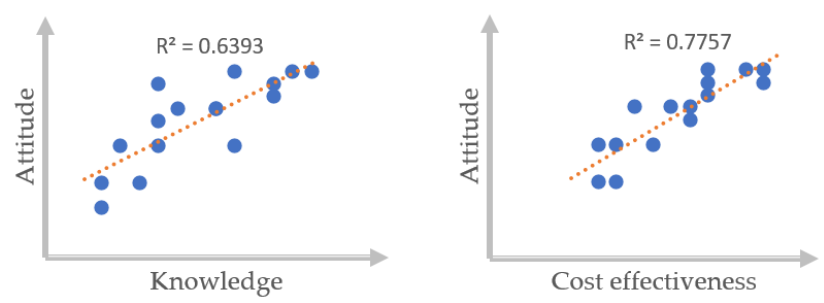
Figure 7. Significant correlations in the transport/logistics/transportation industry.